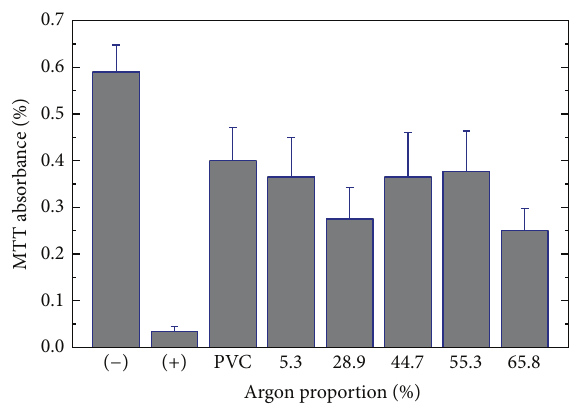
Figure 6: MTT absorbance as an indicator of the cytotoxicity of the bare and coated PVC samples. Films were deposited with different proportions of argon in the plasma. The absorbance of the positive and negative controls is also depicted.